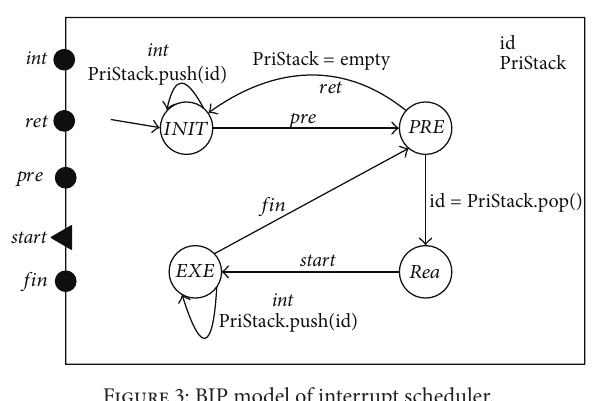
Figure 3: BIP model of interrupt scheduler.